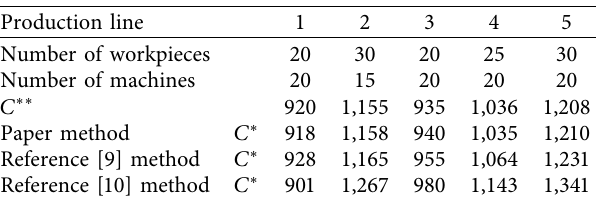
Table 2: Comparison of resource allocation results of three al- gorithms